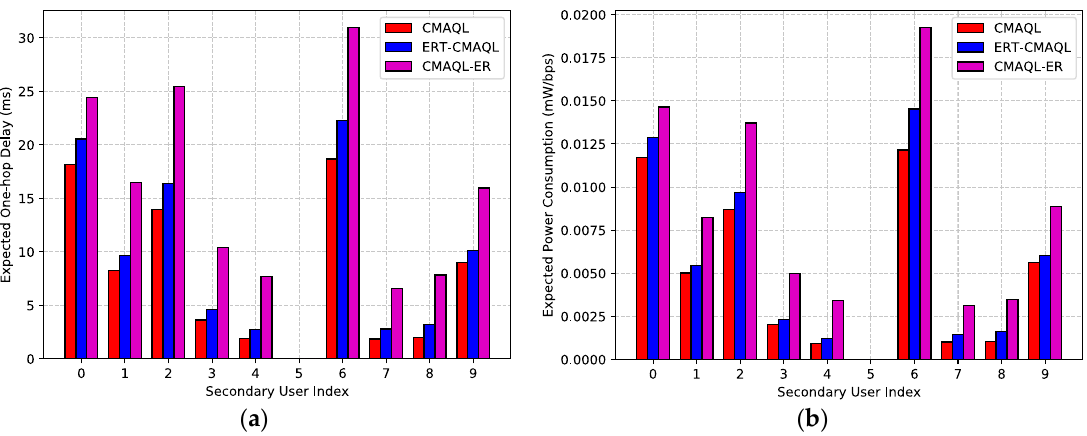
Figure 5. ( a ) Expected single-hop delay and ( b ) expected power consumption.